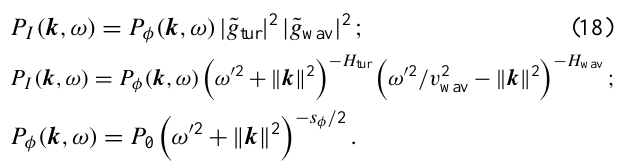
Fig. 1. 1-D spectra from MTSAT data; blue: temporal; or- ange: meridional; purple: zonal and a multivariate regression curved due to the finite empirical domain; black, using H wav =0, V w =41 ± 3kmh − 1 ; τ w = L e /V w ≈ 20 ± 1 days; a ≈ 1.2 ± 0.1; s I ≈ 3.4 ± 0.1; P 0 = 2.8 ± 0.2 ◦ C 2 km 2 h; µ x ≈ − 0 . 3 ± 0 . 1; ( v x ≈ − 12 ± 4kmh − 1 ); µ y ≈ 0 . 10 ± 0 . 08; ( v y ≈ 4 ± 3kmh − 1 ); σ = 0 . 95 ± 0 .